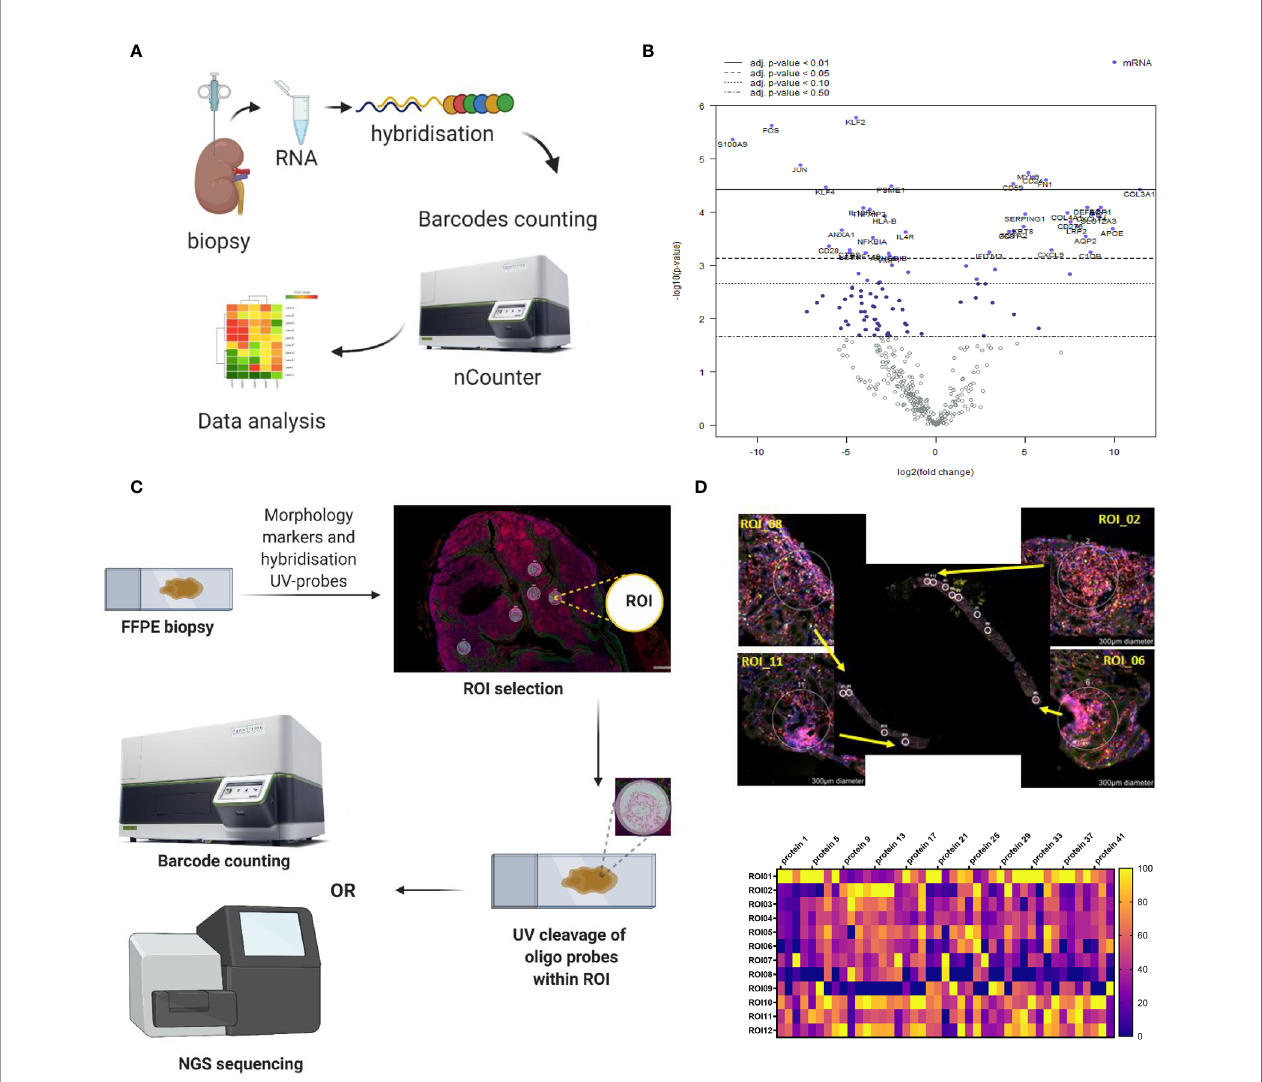
FIGURE 3 | Representative examples of the in situ immune monitoring techniques. (A) Multiplexed gene expression using the nCounter, Nanostring. Schematic of the technique. (B) An example volcano plot obtained using Banff - Human Organ Transplantation (B-HOT) panel on the nCounter system, kidney biopsy versus background of PBMC. (C) Schematic of digital spatial pro fi ling (DSP). (D) Example of kidney biopsy from renal transplant recipient analyzed using DSP (GeoMx, Nanostring). Morphology staining, selected ROIs and heat map analysis are shown. Example of geometric regions of interest (ROIs) and readout with panel of antibodies. FFPE, formalin fi xed paraf fi n embedded; ROI, region of